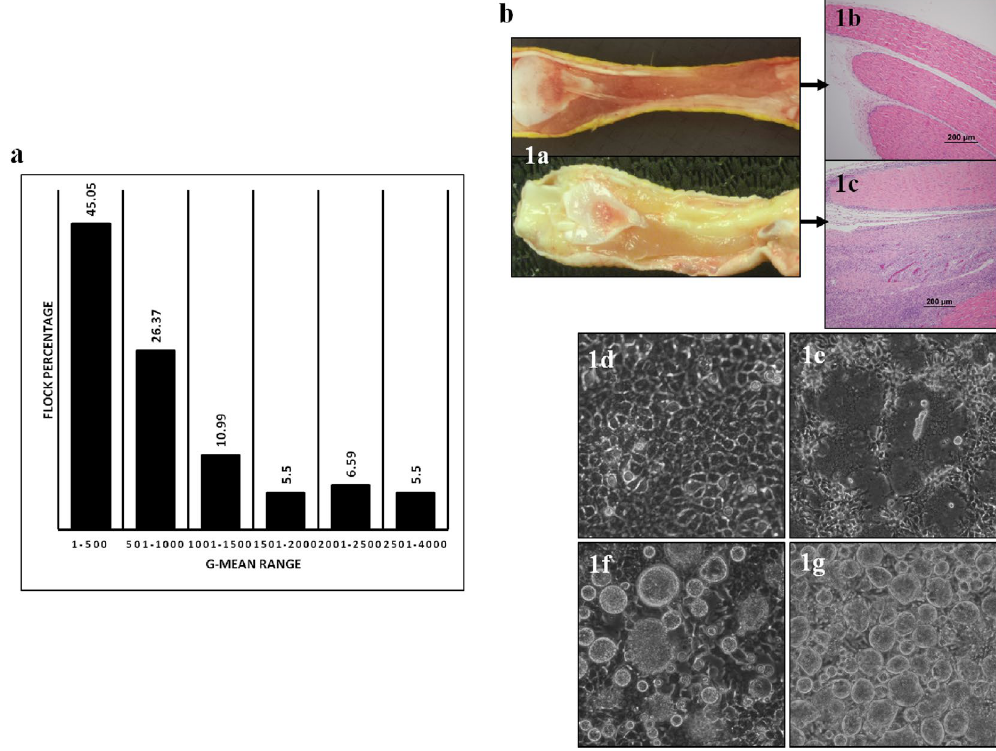
Figure 1. ( a ) The frequency distribution of ARV ELISA geometric means of 59 farms. ( b ) Gross and histopathological lesions in ARV infected tendon tissue, and ARV induced CPE in cell culture. (Panel a) ARV infected and non-infected tendon tissues from broiler chickens. (Panel b) Histology of normal tendon tissue. (Panel c) Lymphocytic plasmacytic infiltration in ARV infected tendon tissue with moderate number of hetrophils. (Panel d) Mock infected LMH cells. Panels (e) (f) and (g) 18, 24 and 36 hr post- infection of LMH cells with an ARV isolate,